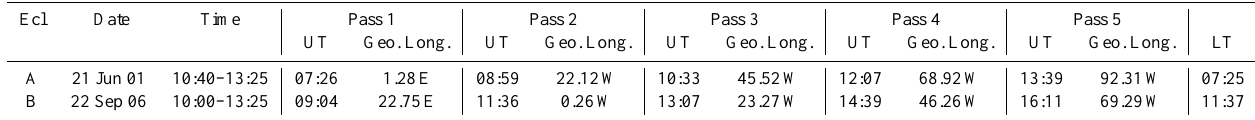
Table 1. Eclipse initial and final times. Location of the equator crossings of the CHAMP passes. Indicated are: Universal time (UT), longitude (in degrees) and Local Time (LT).